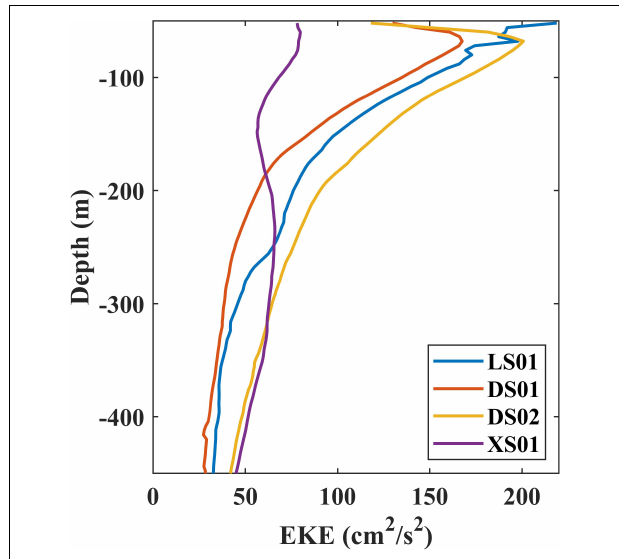
FIGURE 3 | Vertical structure of time-averaged 10–110-day eddy kinetic energy (cm 2 /s 2